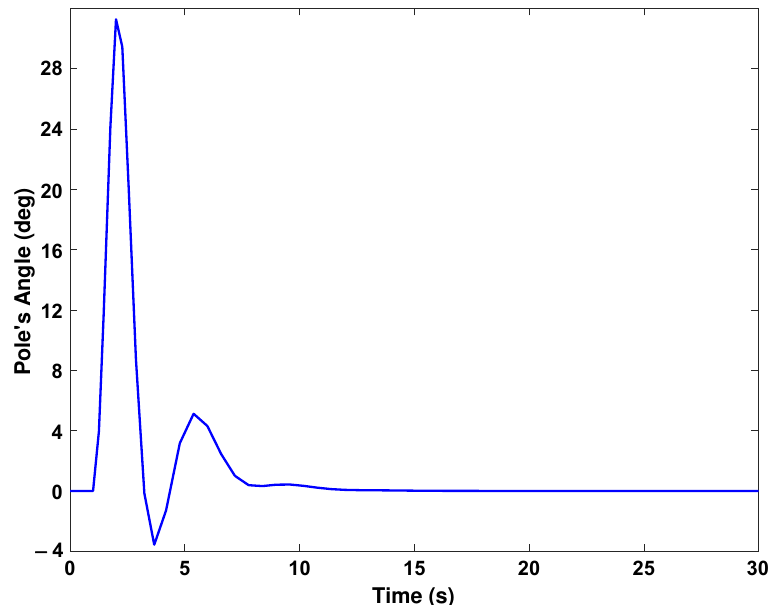
Figure 4. Angle control of inverted pendulum by FRC.